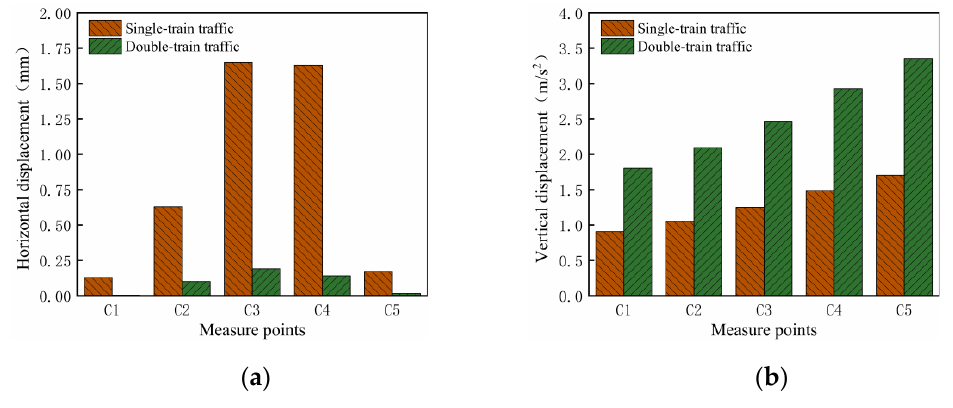
Figure 13. PP D of measuring point: ( a ) PPHD ; ( b ) PPVD . Figure 13. PPD of measuring point: ( a ) PPHD ; ( b ) PPVD